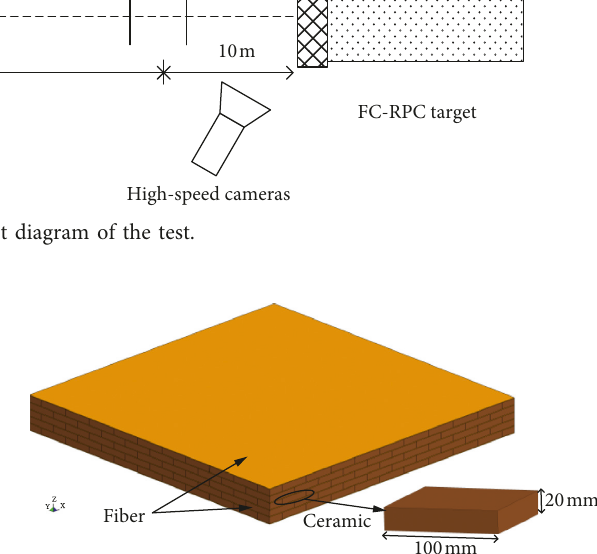
Figure 7: Separate model of the FC